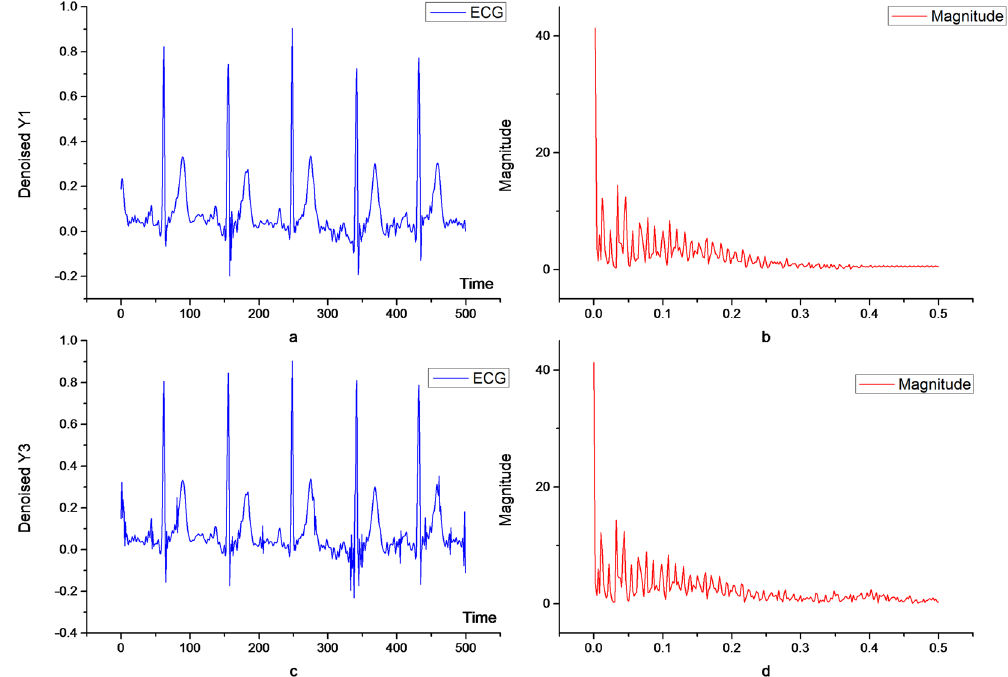
Figure 8. Original ECG signals filtered once ( a , b ) and twice ( c , d ) through the band-pass filter.